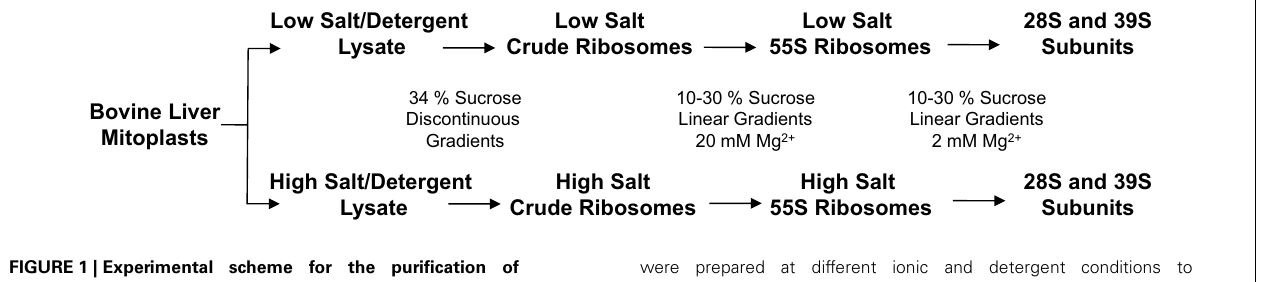
were prepared at different ionic and detergent conditions to remove mitochondrial metabolic enzymes co-sedimenting with the mitochondrial ribosome. Experimental details are included in Materials and